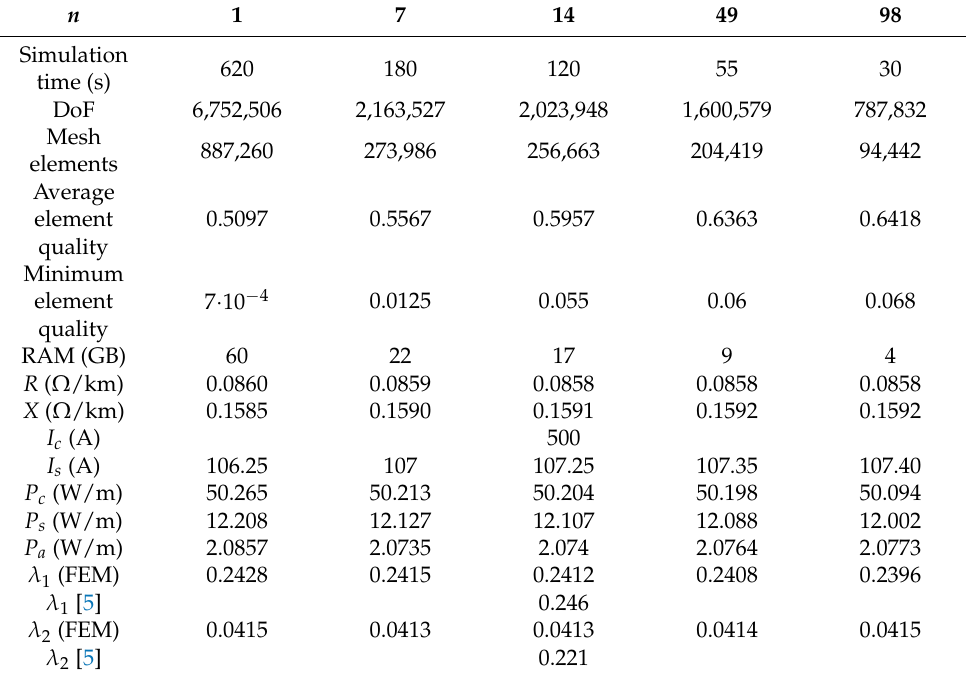
Table 2. Results for different values of n in a 115 kV, 240 mm 2 TCAC ( θ = 20 ◦ C